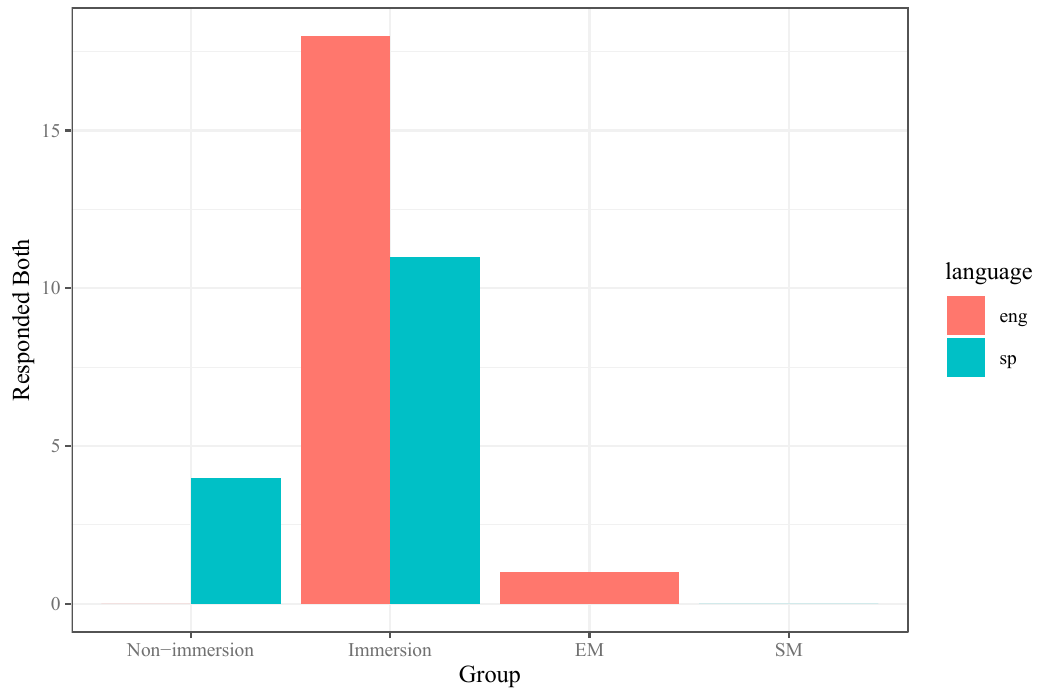
Figure 4. Number of times that children responded that both null and overt sounded correct.